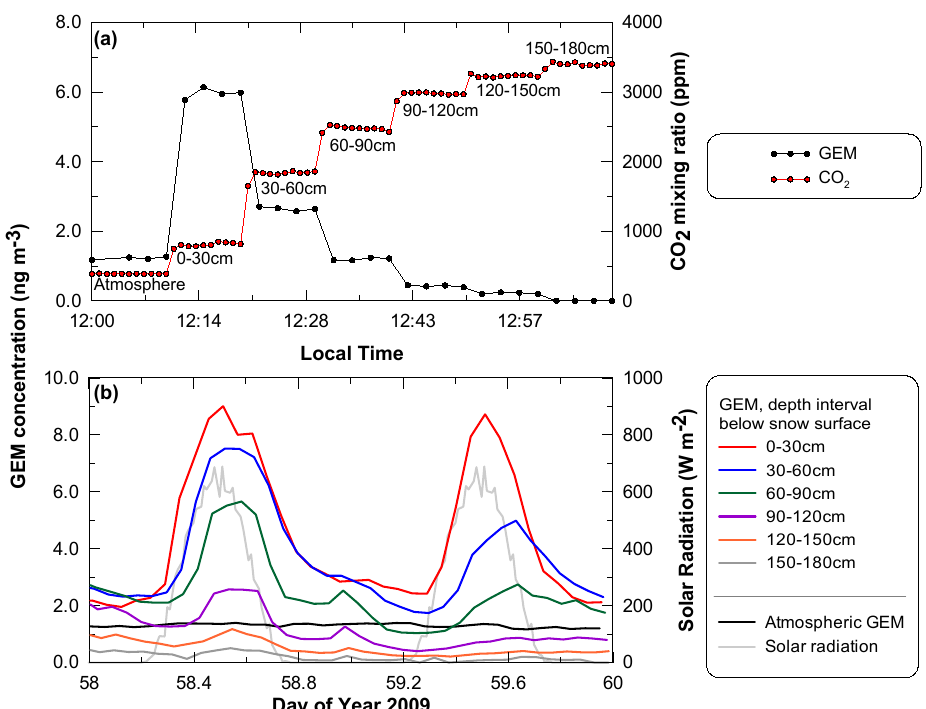
Fig. 1. (a) Time series of GEM and CO 2 mixing ratios during one sampling cycle from the snowpack gradient sampling tower on 1 March 2009. This 70min sampling started with 10min of measurements in ambient air above the snow, and then moved downward in 10min intervals towards the bottom of the snowpack (six measurement heights in the snow). Total snowpack depth at this time was 162cm. (b) GEM concentrations collected at the six levels in the snowpack and in the atmosphere above the snow (black line) from 27 to 28 February 2009. Snow height was 155cm during this period. The gray line shows the diurnal solar irradiation cycle (Wm − 2 )